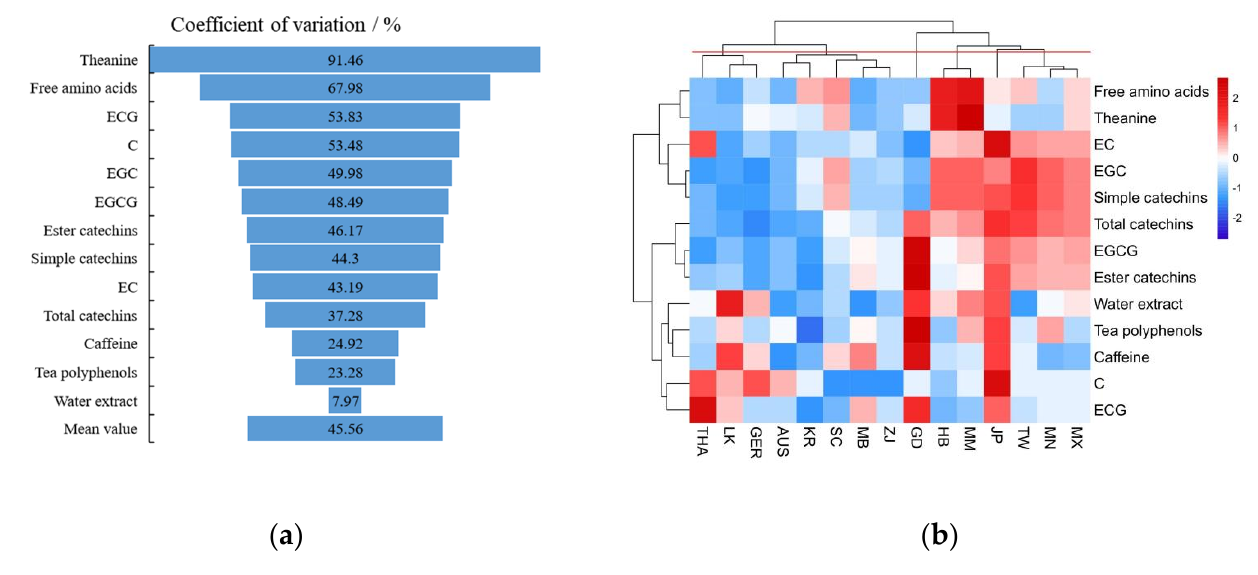
Figure 3. Coefficient of variation ( a ) and heat map analysis ( b ) of phytochemical components of Oolong tea from different regions. ( b ) Red indicates high content and green indicates low content.